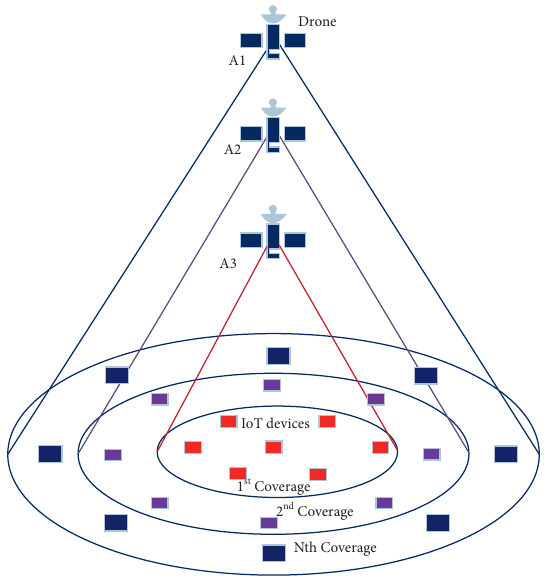
Figure 7: Strength of signal in various